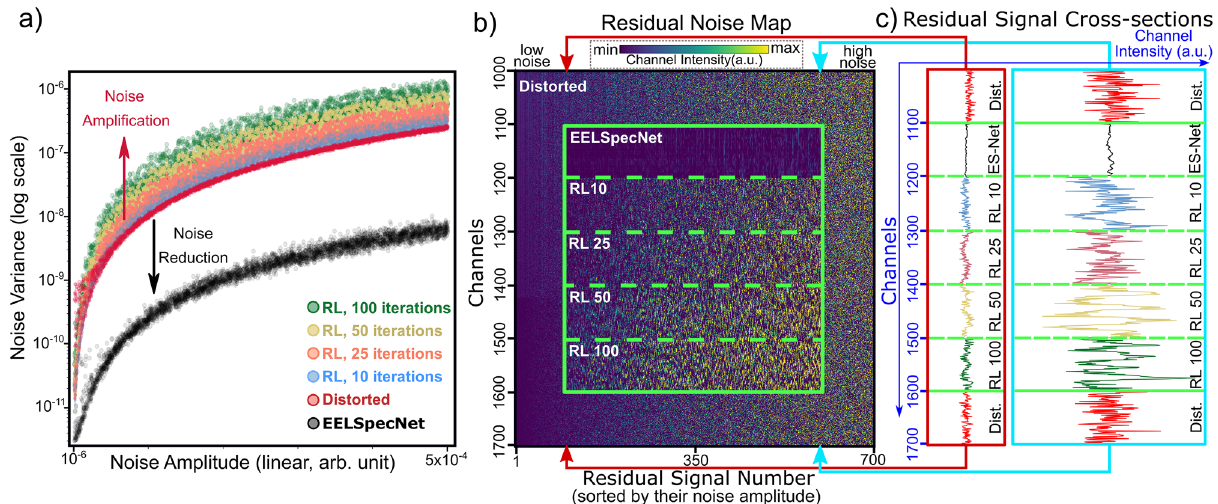
Figure 4. ( a ) Measured noise variance in each spectrum in a set of 4000 generated spectra before deconvolution (distorted signal) and after deconvolution using EELSpecNet and different iterations of the RL algorithm. ( b ) The residual noise map demonstrates the feature-less channels (no peaks) of the first 700 distorted spectra from the 4000 spectra generated for noise evaluation. Each spectrum is put on vertical axes and they are sorted by their noise amplitude in the distorted data. The green box represents snapshots of channels deconvolved using different methods. ( c ) slices of a residual noise map at low and high noise amplitudes are demonstrated.